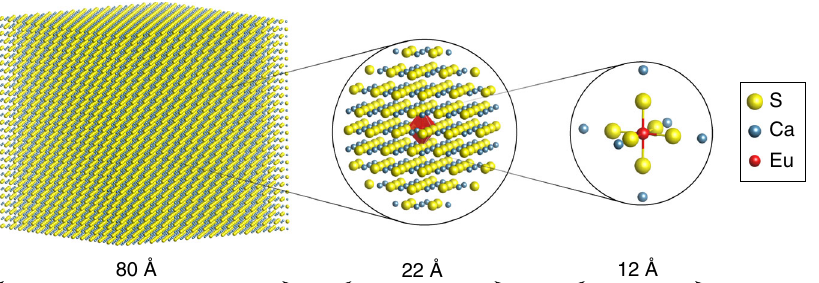
Fig. 5 Embedded cluster calculations. Graphical representation of the simulated system and how it is divided in the (LnS 6 M 6 ) 2 + /3 + (M = Ca, Sr and Ln = Eu, Tb) cluster, which is treated at the highest level of theory (right), subject to the embedding potential composed of the full-ion ab initio model potentials (AIMP) of the 316 ions in the next four coordination shells (middle) and 24,389 point charges at the crystal lattice sites (left). The indicated distances are for CaS and are slightly larger for SrS. Table 1 Calculated spectroscopic parameters.